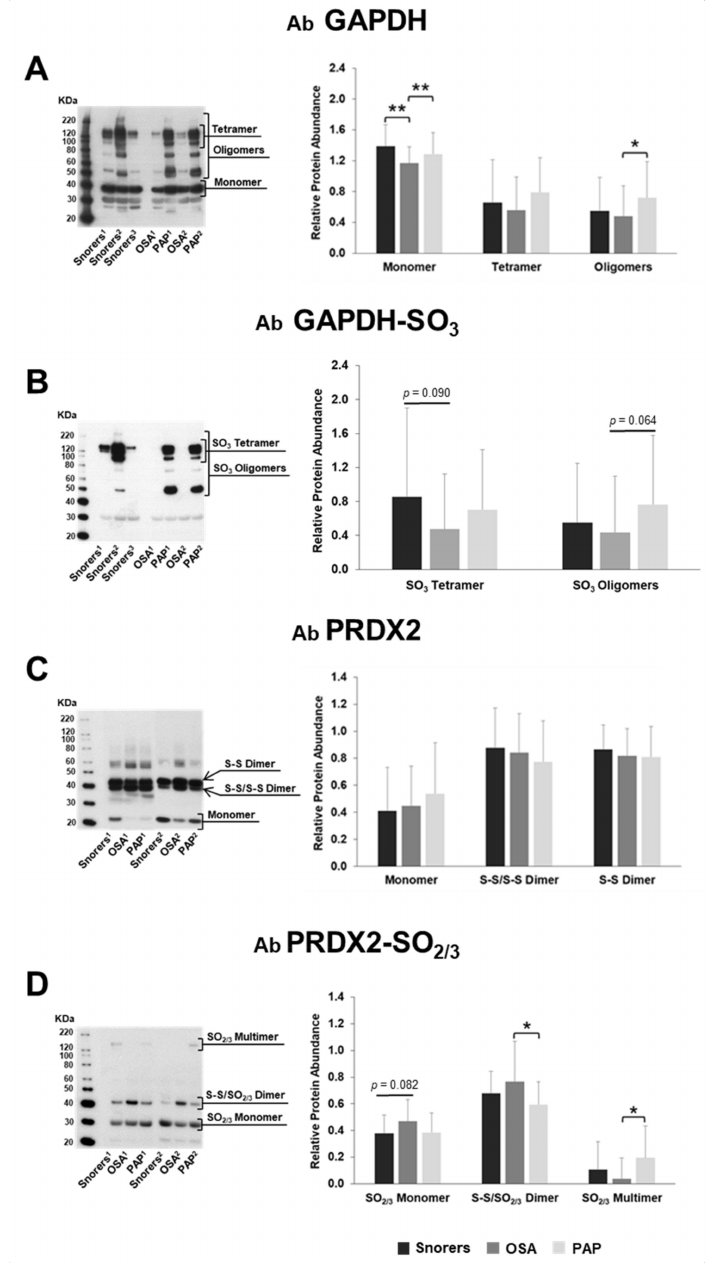
Figure 3. Western blot (WB) validation of the proteomics data showing changes in GAPDH and PRDX2 redox / oligomeric states in RBC isolated from Snorers and OSA patients before or after PAP treatment. On the left, representative non-reducing SDS-PAGE WB fluorograms of RBC proteins immunoreactive to the antibody (Ab) GAPDH ( A ), Ab GAPDH-SO 3 ( B ); Ab PRDX2 ( C ) or Ab PRDX2-SO 2 / 3 ( D ). On the right, the respective graphic plots of GAPDH ( A , B ) and PRDX2 ( C , D ) redox / oligomeric form relative normalized protein abundances calculated by densitometric analysis (see Material and Methods). Statistically significant di ff erences ( p < 0.05) and ( p < 0.01) between groups are indicated (*) and (**),